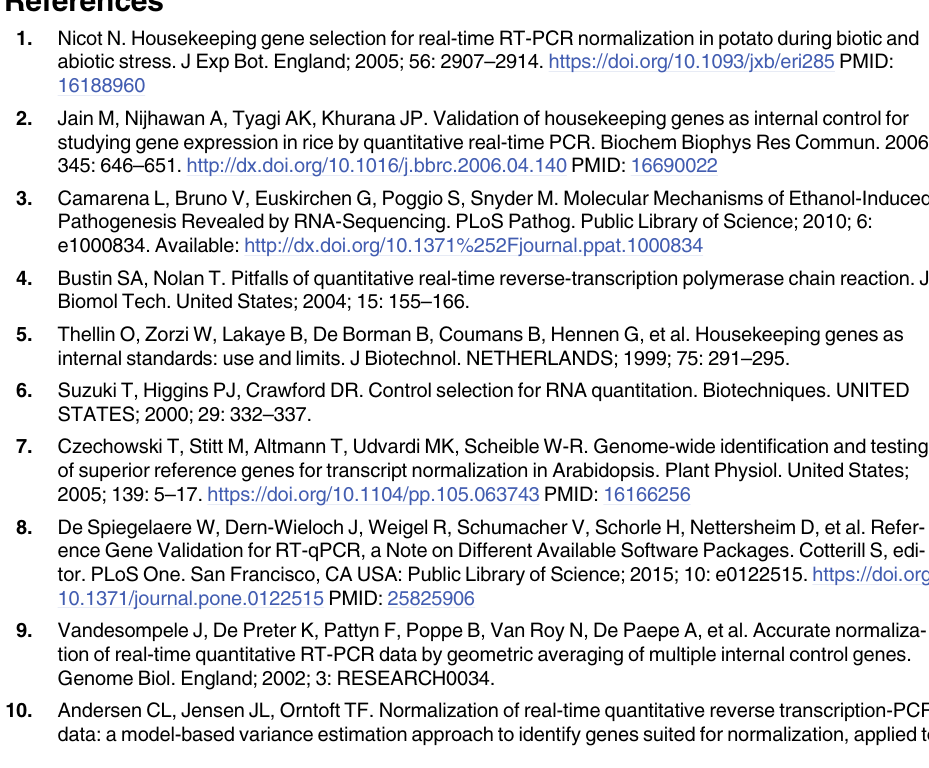
S1 Table. Descriptive statistic analyses by BestKeeper. Transcriptional regulation of twelve candidate reference genes tested in shoots and roots of one japonica (Nipponbare) and two contrasting indica (Epagri 108 and IRGA 409) cultivars subjected to iron treatment (500 mg L -1 FeSO .7H O at pH 4.0 ± 0.1), for 0, 12, 24 and 36 hours, using the software BestKeeper. 4 2 Absent data (-) corresponds to unviable calculations due to differentially regulated transcrip- tion under the given experimental